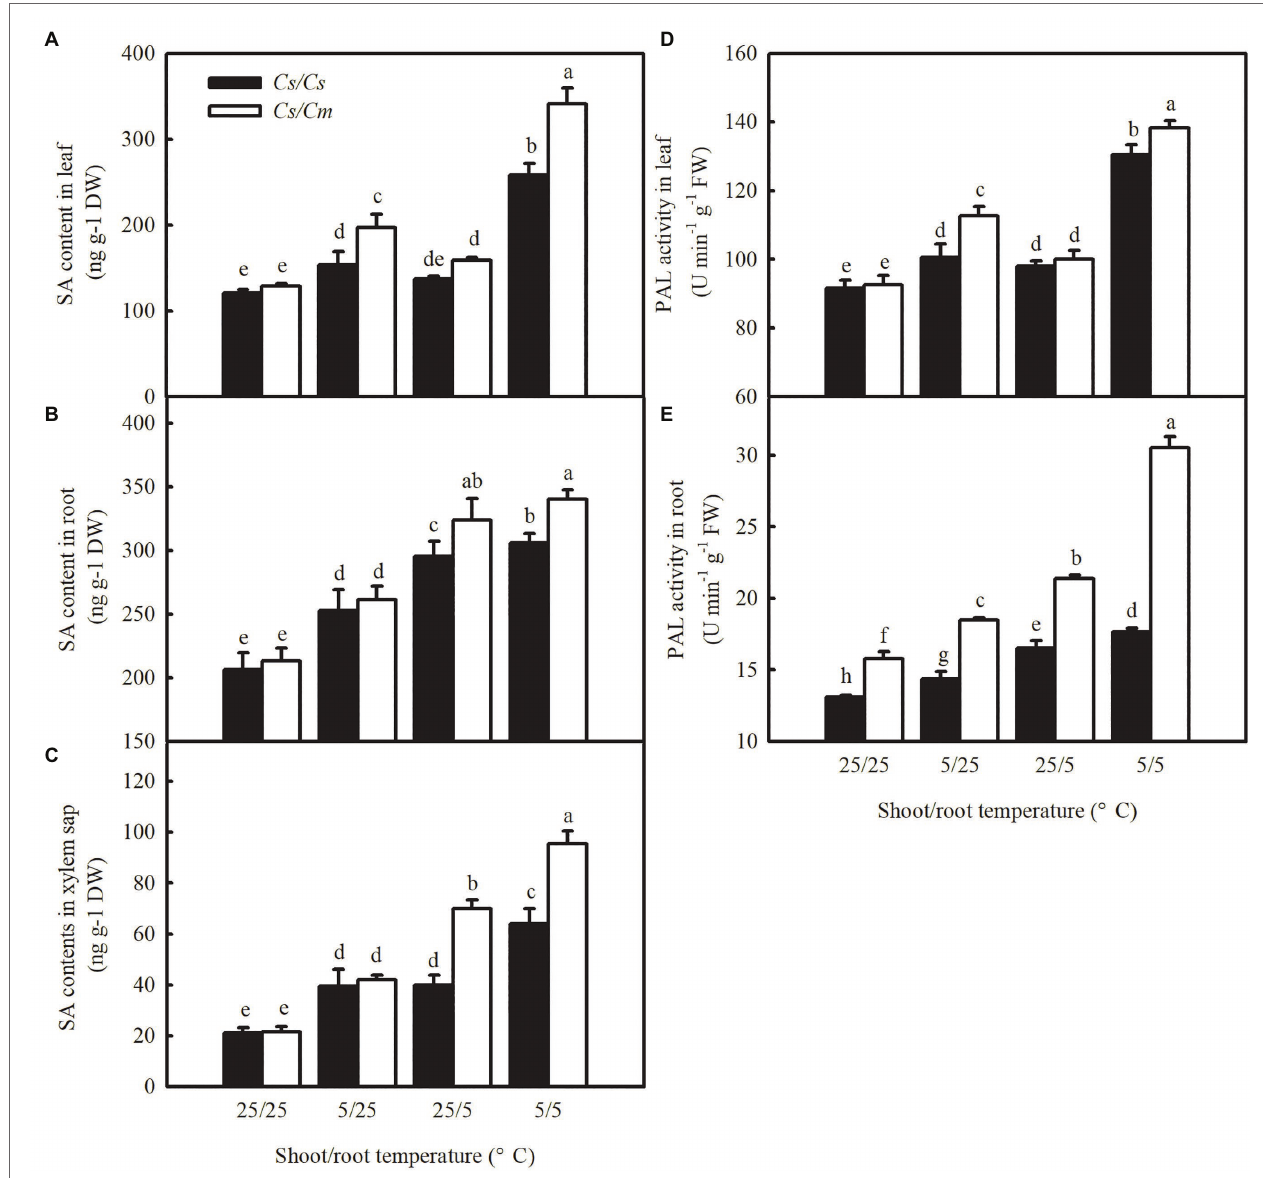
FIGURE 6 | SA accumulation and PAL activity in leaves, roots, and xylem sap under aerial and/or chilling stress in Cs/Cs and Cs/Cm plants. (A–C) SA content in leaves, roots, and xylem sap, respectively; (D,E) PAL activity in leaves and roots, respectively. The third leaf of three-leaf stage seedlings was sampled at 12 h after chilling treatment. Data are the means of four replicates (±SDs). Different letters indicate a significant difference between samples according to Duncan’s new multiple range test ( p <